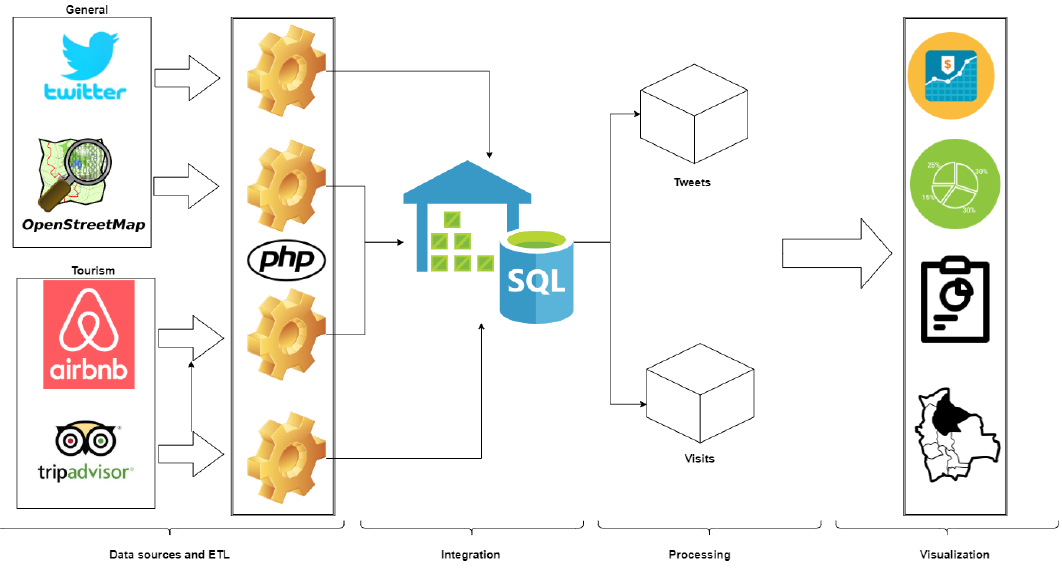
Figure 3. Architecture of BITOUR